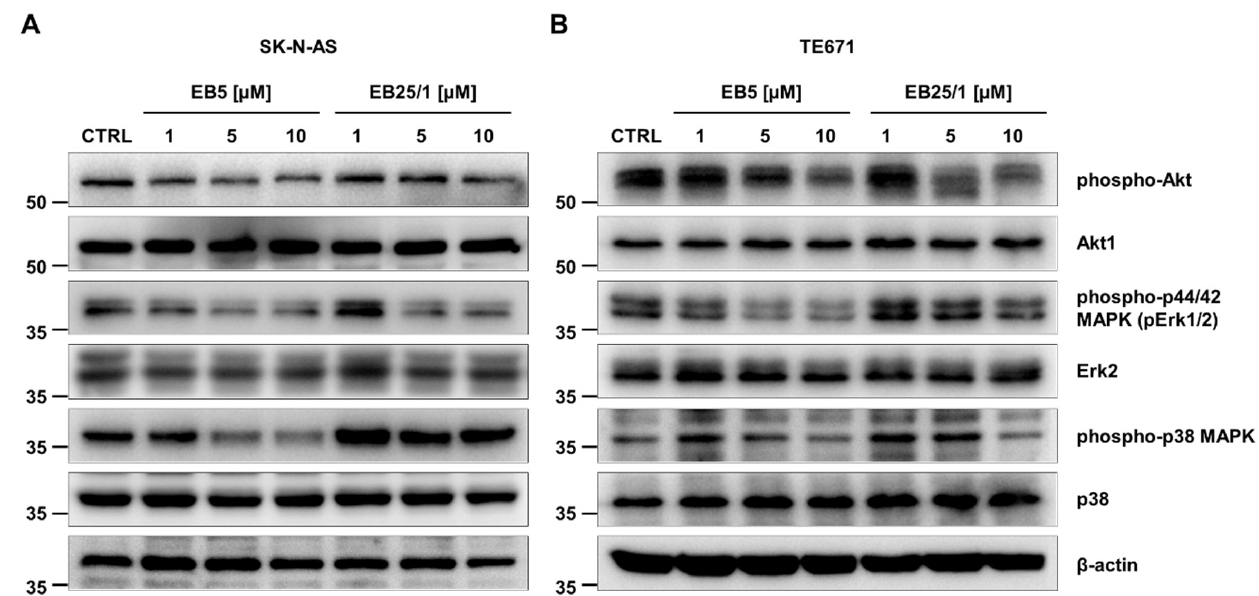
Figure 5. ASBDs inhibit phosphorylation of kinases crucial for growth and proliferation of cancer cells. SK-N-AS and TE671 cell lines were treated with selected concentrations of ASBDs for 3 h and then analyzed with Western blotting for kinases activation. ( A ) Representative immunoblots show the level of phosphorylated Akt and MAP (Erk1/2 and p38) kinases in SK-N-AS cell line after treatment with ASBDs. ( B ) Representative immunoblots show the level of phosphorylated Akt and MAP (Erk1/2 and p38) kinases in TE671 cell line after treatment with ASBDs. Total: Akt1, Erk2, p38 and β -actin were used as the loading controls for an equal amount of protein. Control cells (CTRL) were treated with 0.1% DMSO as a solvent control.